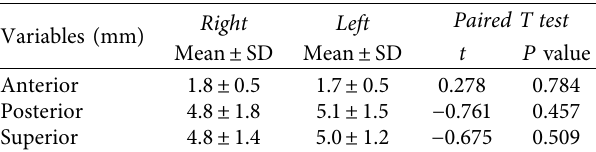
Figure 1: Linearly measurements of joint spaces between the condyle and the glenoid fossa. Table 1: Te mean and standard deviation (SD) for joint spaces of right and left condylar positions ( n �